Question: Express in one sentence what the figure is showing.
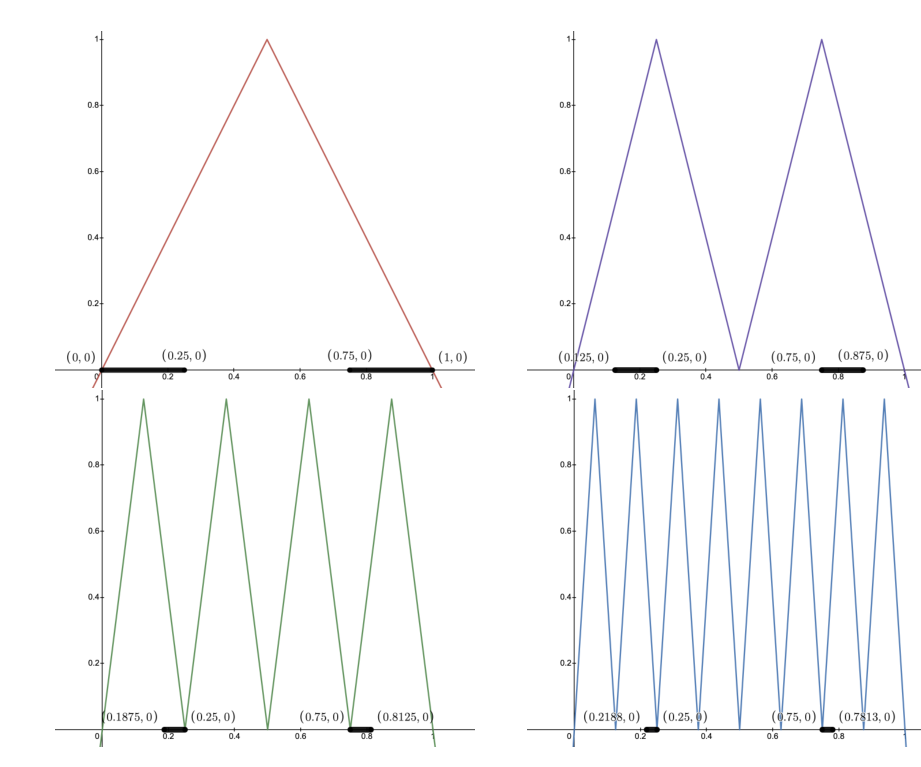
Answer: The graph on the top left represents the first iteration of the tent map, with the black intervals representing the points A(1) of [0, 1] such that g(f[A(1)]) = c1 = 0. The graph on the top right represents the second iteration of the tent map, f 2, with the black intervals representing the subset A(2) of A(1) such that g(f 2[A(2)]) = c2 = 1. Similarly, the bottom left and right graphs represents the third and fourth iterates of the tent map with the black intervals representing the subsets A(3), A(4) with A(4) ⊂A(3) ⊂A(2) ⊂A(1) such that g(f 3[A(3)]) = c3 = 0 and g(f 4[A(4)]) = c4 = 0. Note that the length of the black intervals representing candidate secret initial conditions is halved with each iteration of the algorithm.